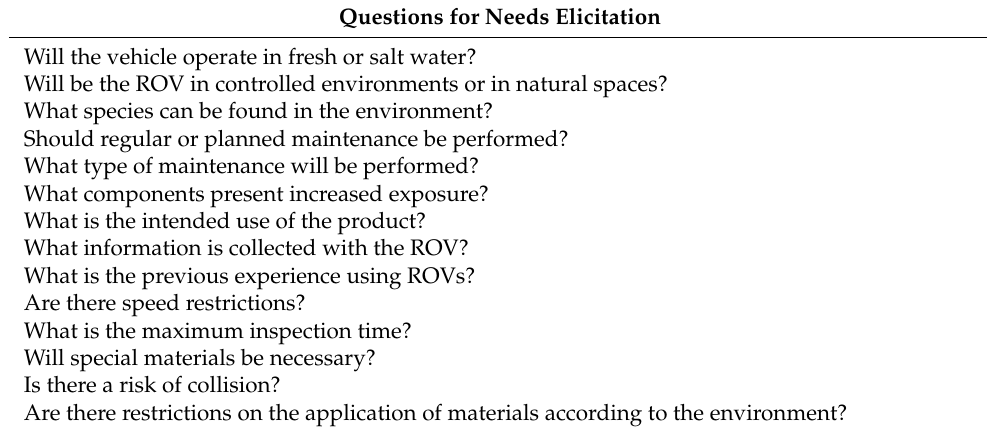
Table 2. Proposal for the characterization of the obtained PDS.